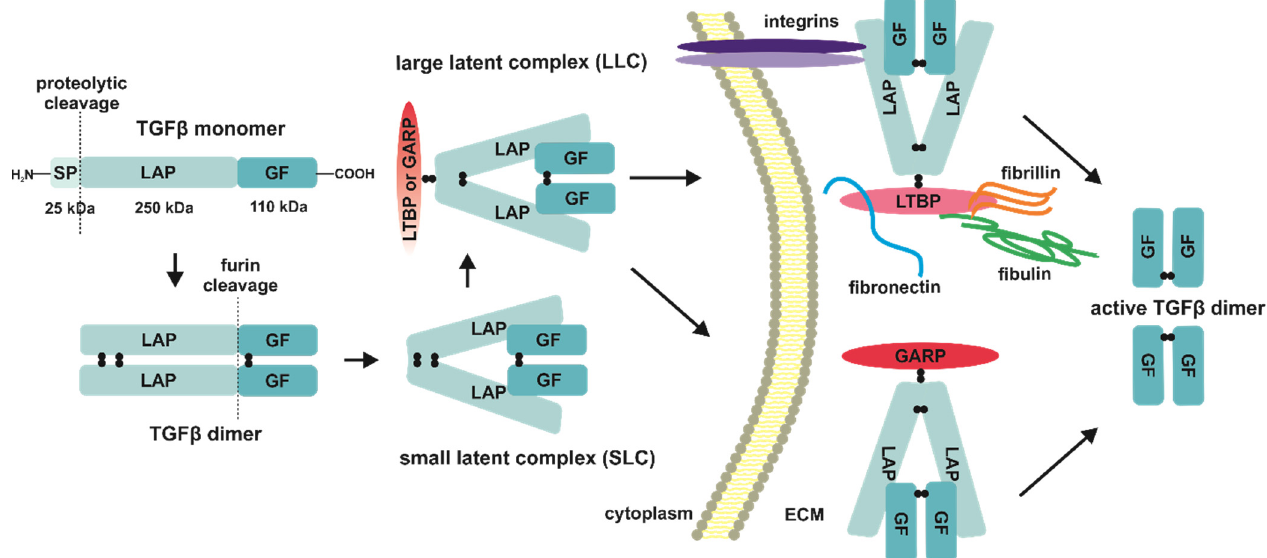
Figure 1. TGF β isoforms processing, secretion, deposition, and activation. A series of molecular events is presented from left to right and guided by black arrows. The TGF β ligands are synthesized as precursors—pre-proproteins. After biosynthesis and proteolytic cleavage of SP, two TGF β monomers aggregate noncovalently with the following disulfide bonds formation between LAP prodomains and GF domains of each monomer. The next step in the TGF β ligands biosynthesis is the removal of LAP prodomains by furin proteases. The LAP peptides stay noncovalently bound to pro-TGF β dimer, and that bimolecular aggregate is called SLC. The secretion of native TGF β ligands is preceded by the interaction of SLC with LTBP or GARP, forming the LLC. LTPB or GARP proteins being disulfide-bound to LAP determine temporary inactivation of LLC by increasing its half-life and sequestration of TGF β dimers in extracellular space after secretion, through the interactions with fibrillin, fibronectin, or fibulin. The C-terminus of LAP also allows its binding with integrins. SP: signal peptide; LAP: latency-associated peptide prodomain; GF: growth factor; LTPB: latent TGF β -binding protein; GARP: glycoprotein-A repetitions predominant protein; ECM: extracellular matrix.